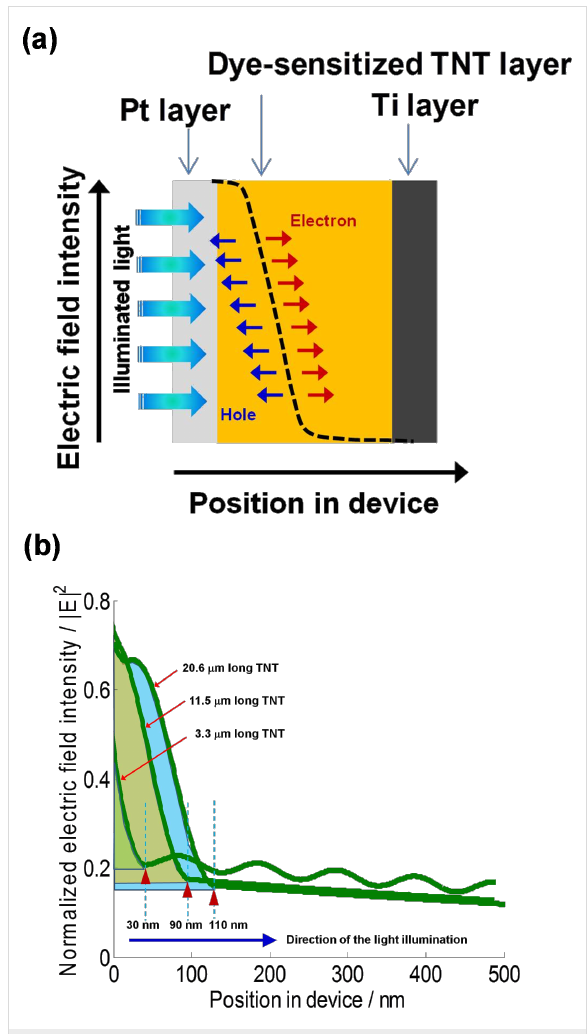
Figure 5: (a) A schematic diagram of charge separation driven by the electric field intensity as a function of layer thickness and (b) Electric field intensity of DSSCs with different TNT lengths calculated by using GTMM. (The onset values, 30 nm, 90 nm, and 110 nm, are electric field-valid layer thickness. That is the distance from the Pt